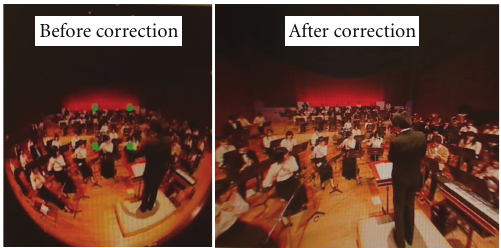
Figure 8: Distorted image and corrected image.